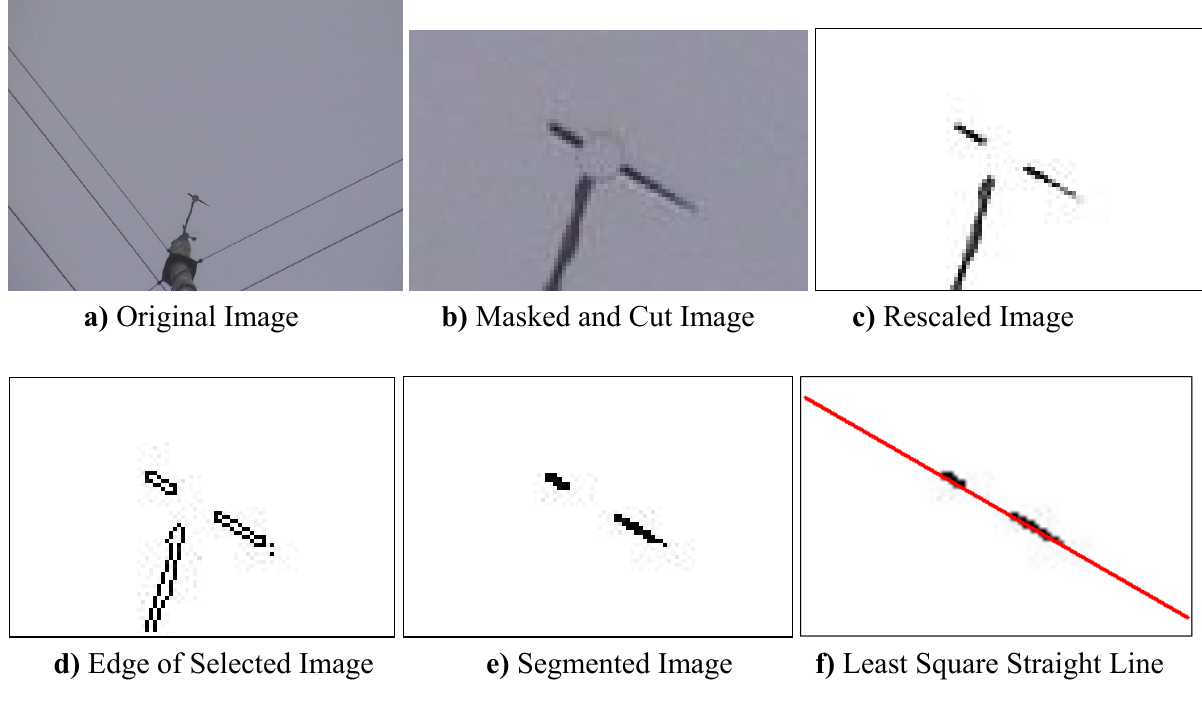
Figure 3. Procedure of image data analysis to